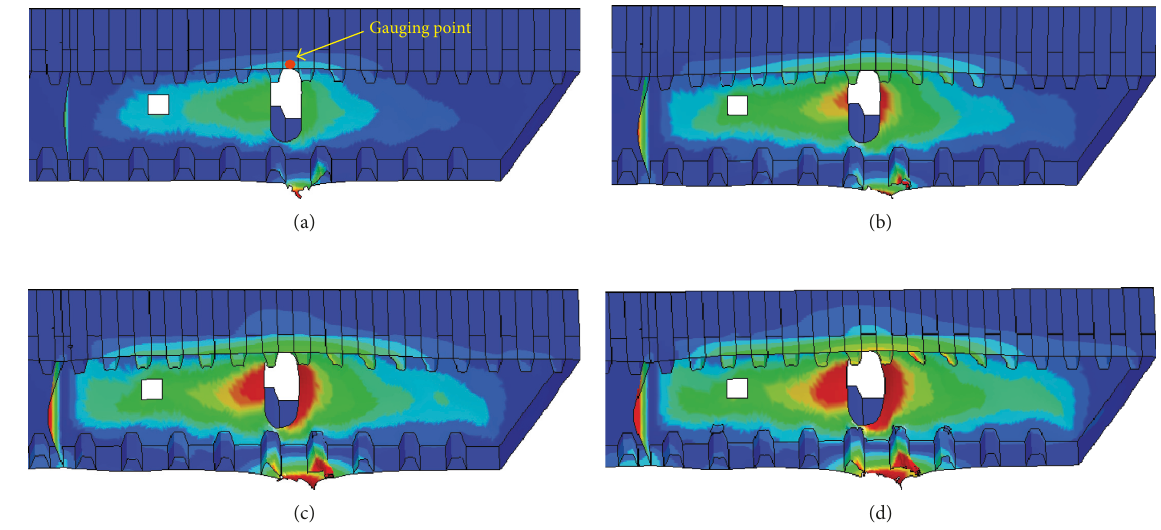
Figure 19: Damage features of different explosive masses in position 2. (a) 10kg TNT. (b) 23kg TNT. (c) 36kg TNT. (d) 50kg TNT.